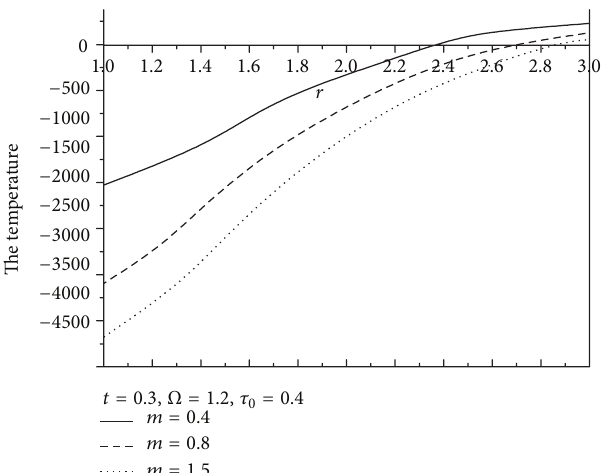
Figure 10: Variation of tangential stress 𝜎 𝜙𝜙 with radius 𝑟 (thermoe- lastic nonhomogeneity